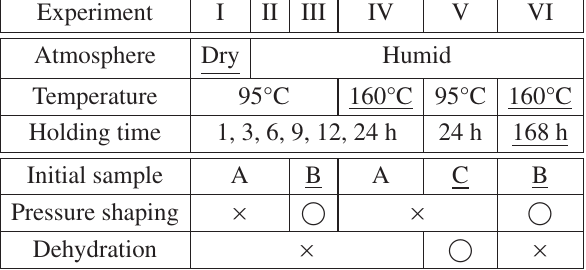
Table 1. Conditions of the crystallization experiments